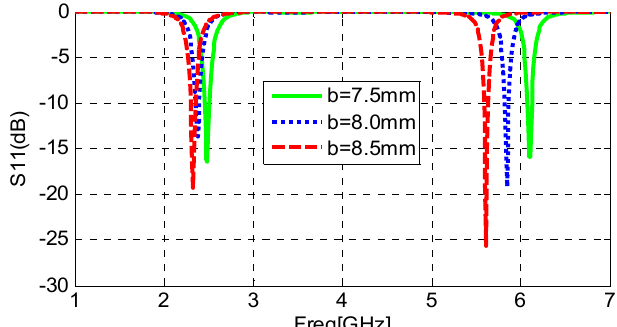
Fig. 4. Influence of length a on resonating frequency